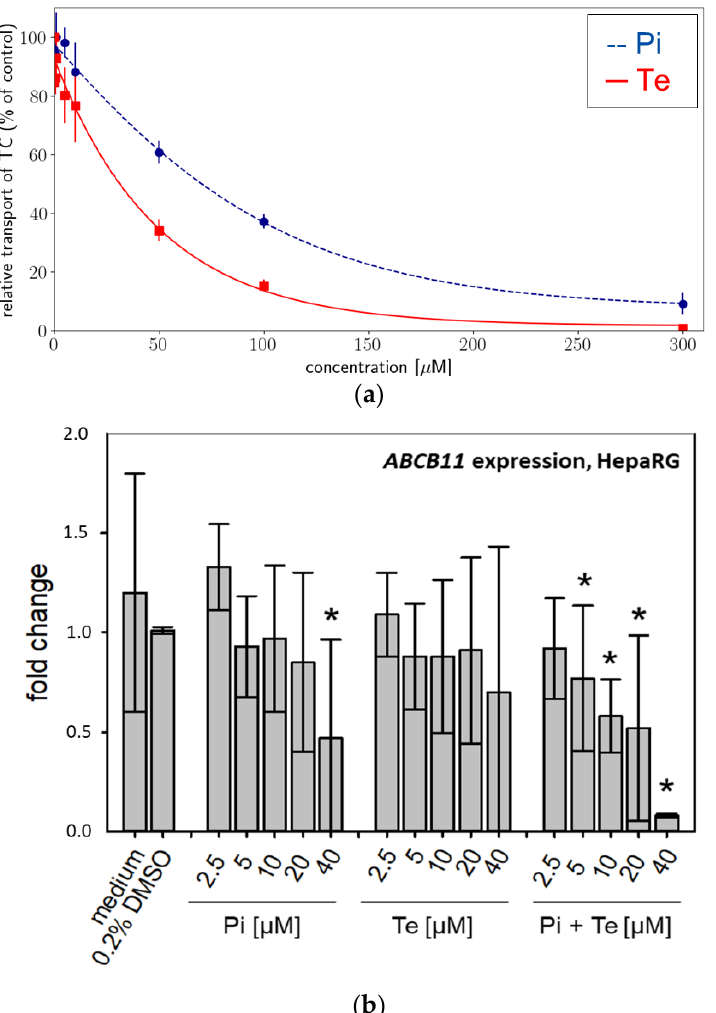
Figure 2. Effects on bile salt export pump (BSEP) activity and expression. ( a ) In vitro activity of BSEP in HEK293 cell membrane preparations in the presence of increasing concentrations [0–300 µ M] of propiconazole (Pi; blue dashed line) or tebuconazole (Te; red solid line) expressed as relative taurocholate (TC) transport against the solvent control. ( b ) Gene expression of ABCB11 (the gene encoding BSEP) after 24 h of treatment with Pi, Te, and their equimolar combination (Pi + Te) from 2.5 µ M to 40 µ M in HepaRG cells. Statistical significance was reached at p < 0.05 and is indicated by asterisks (Mann–Whitney rank sum test against the solvent